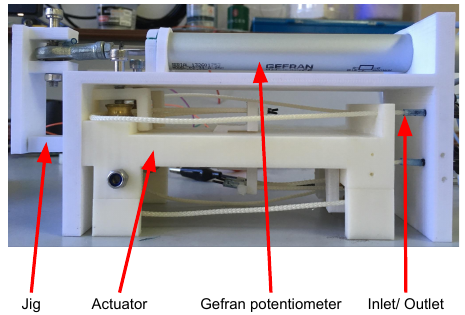
Figure 7. The prototype fitted with a Gefran potentiometer.